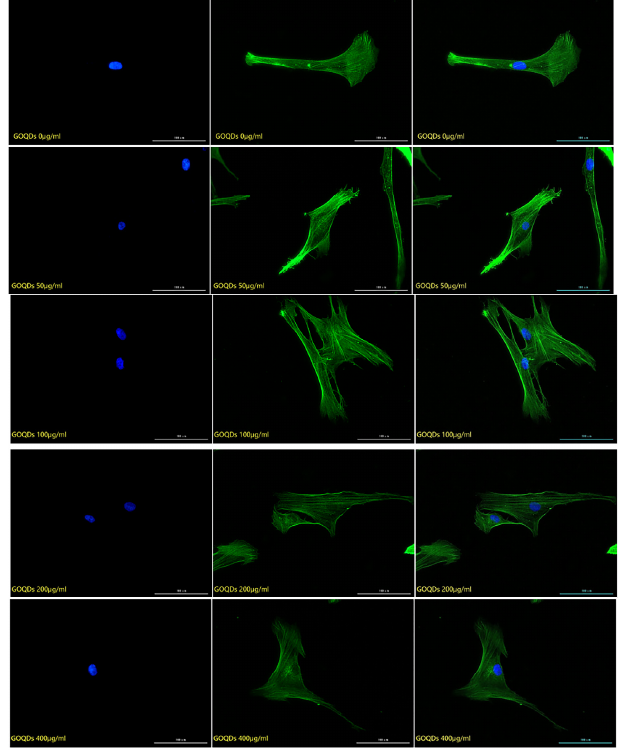
Figure 4. The fluorescence map of FITC-DAPI cytoskeleton staining of HSFs labeled with GOQDs, scale bar: 100 μ m.